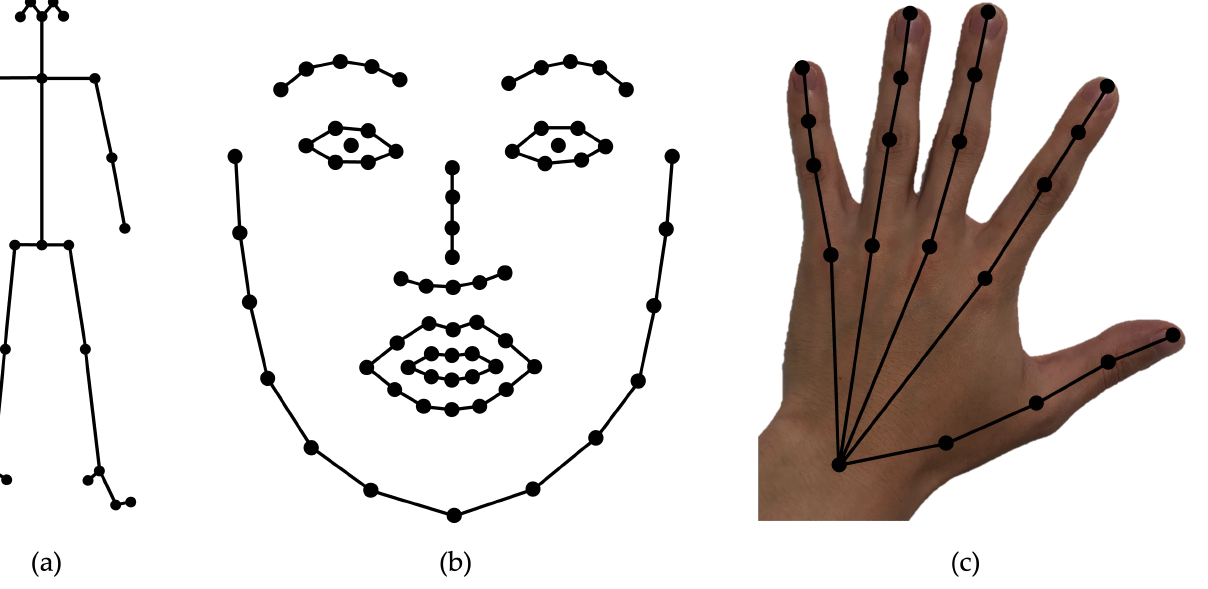
Figure 3. Keypoints extracted using OpenPose : ( a ) 25 keypoints extracted from the body; ( b ) 70 key- points extracted from face; ( c ) 21 keypoints extracted from one